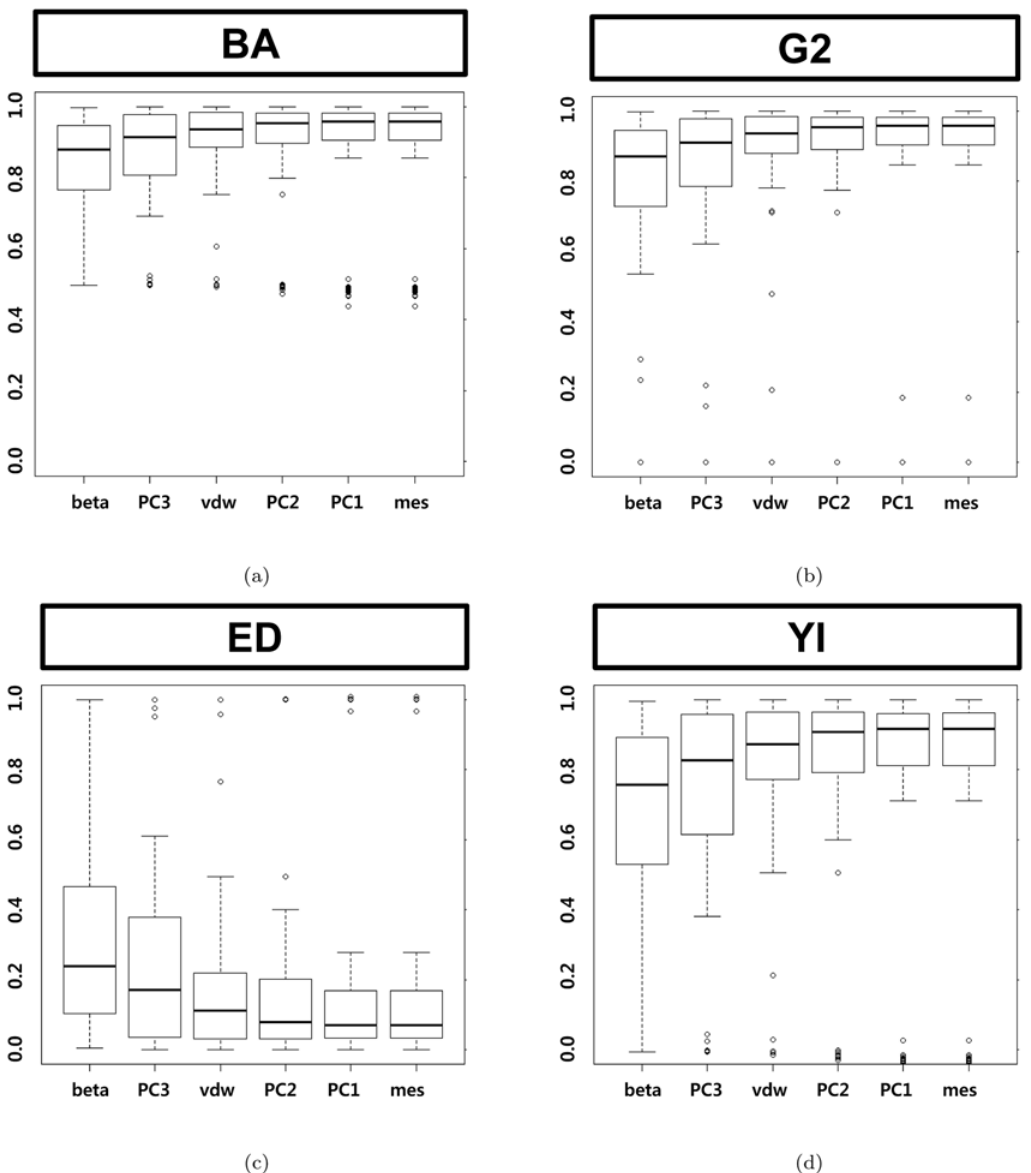
Fig 6. Box plots by ROC-based metrics of the six shape descriptors. (a) Balanced accuracy, (b) geometric mean 2, (c) Euclidean distance and (d) Youden